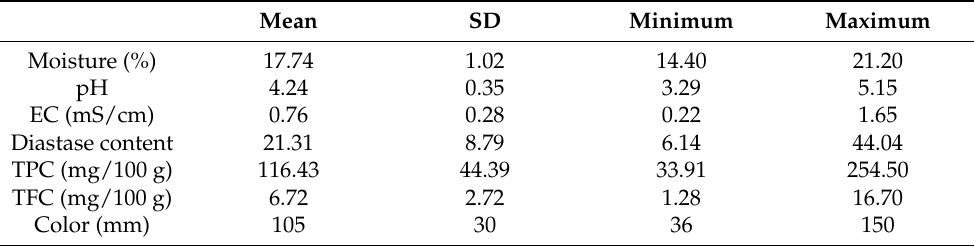
Table 2. Descriptive analysis of the physicochemical parameters determined in the set of honey samples. SD: standard deviation, EC: electrical conductivity; TPC: total phenol content; TFC: total flavonoid content.